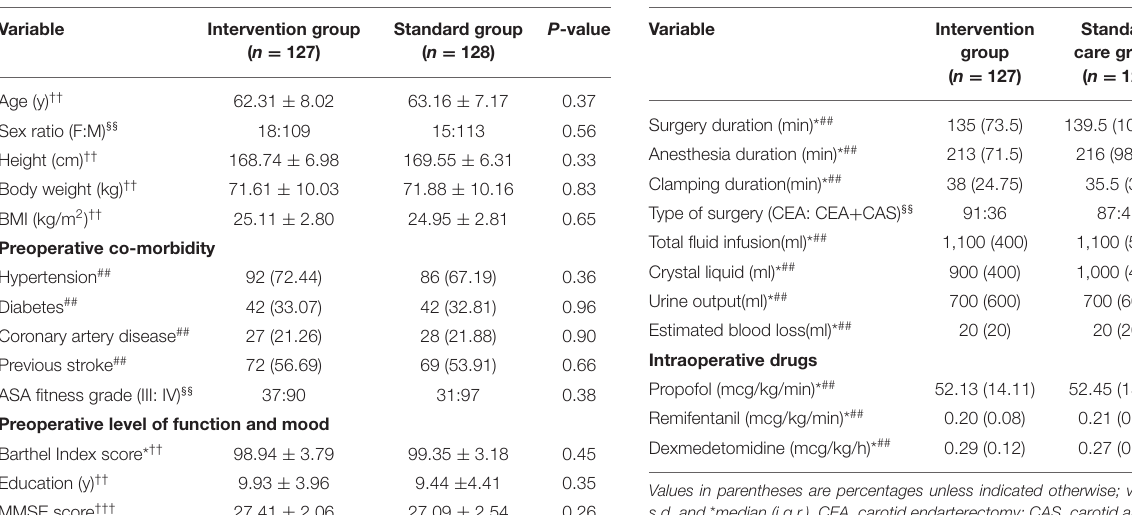
TABLE 1 | Patient demographic and clinical information. TABLE 2 | Intraoperative variables.